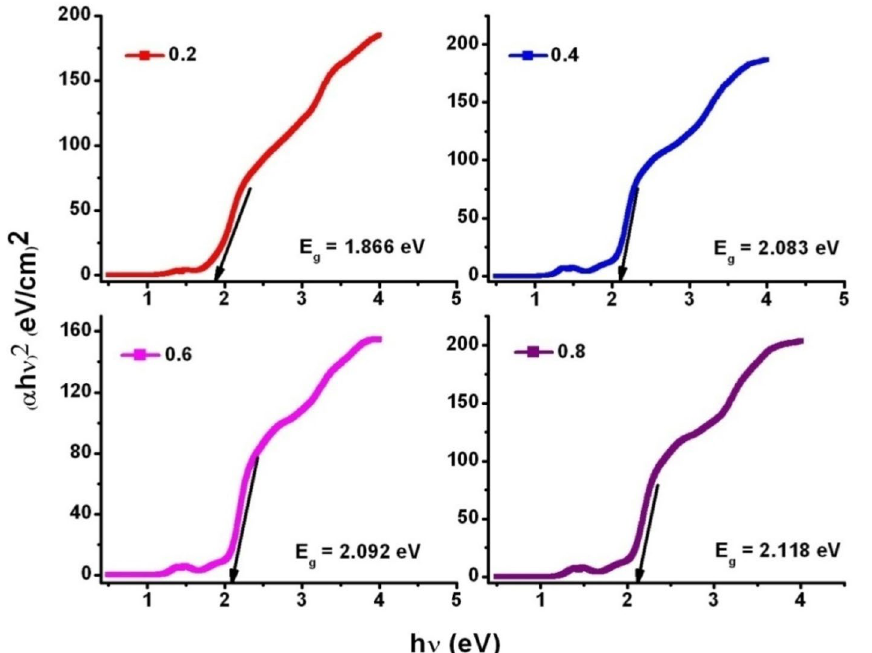
Figure 8. Optical bandgap determination of SLFO